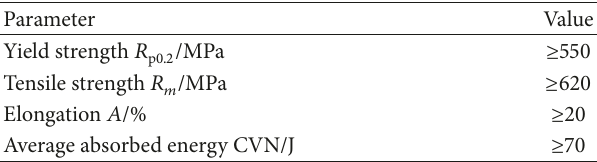
Table 2: Mechanical properties of API X80 (20 ∘ C). Parameter